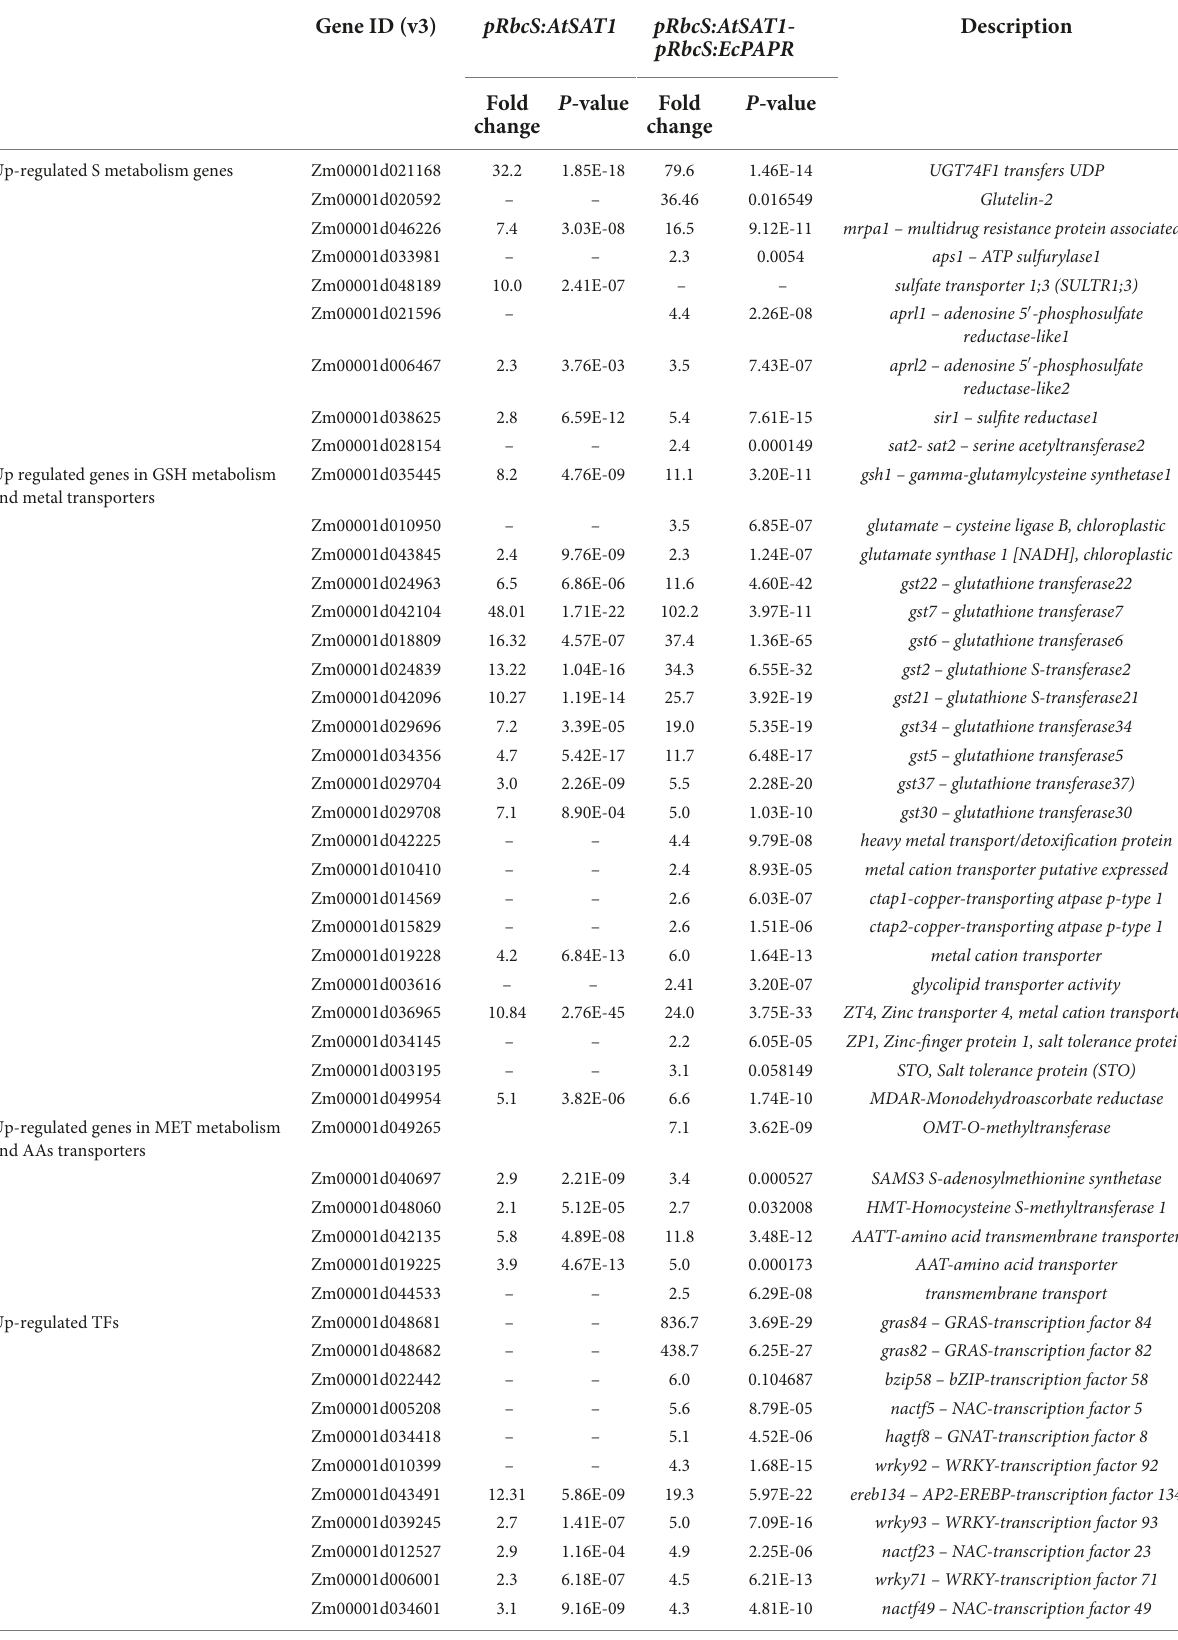
TABLE 1 Partial Up-regulated genes in pRbcS:AtSAT1 and pRbcS:AtSAT1-pRbcS:EcPAPR